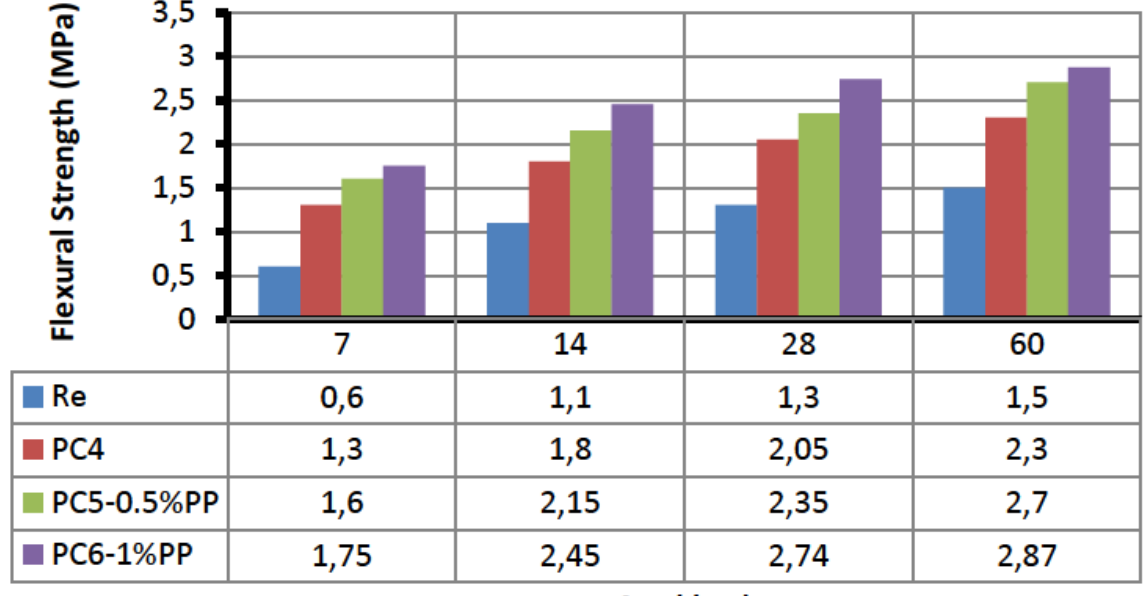
Figure 6: Influence of Sand Size on Flexural Strength of Polymer Concrete with Age